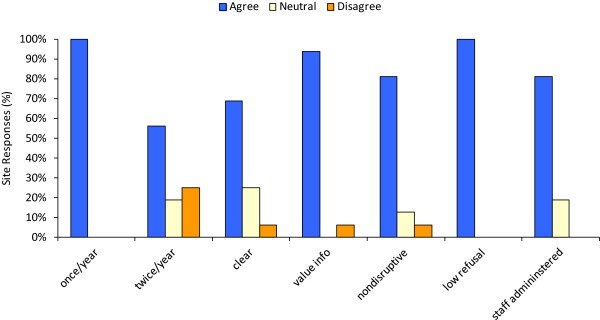
Post-pilot survey. Post-pilot survey responses BC, (N = 28 HR sites). See Figure 3 for complete statements and Likert scale.